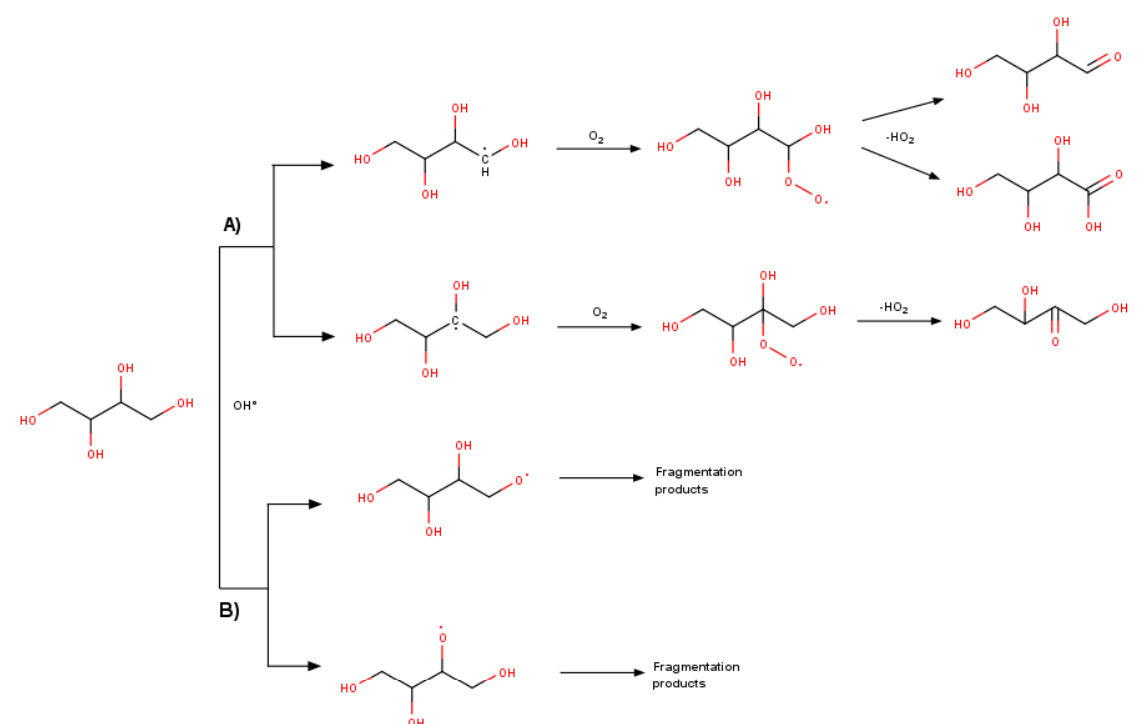
Figure 9. Proposed mechanism of oxidation of erythritol under air. Pathway A: abstraction of hydrogen atom to form alkyl radicals, which in the presence of oxygen are turned into peroxy radicals. Peroxy radicals can undergo the unimolecular HO 2 elimination process yielding carbonyl compounds. Pathway B: abstraction of hydrogen atoms to form alkoxy radicals, which undergo decomposition via C-C bond scission.